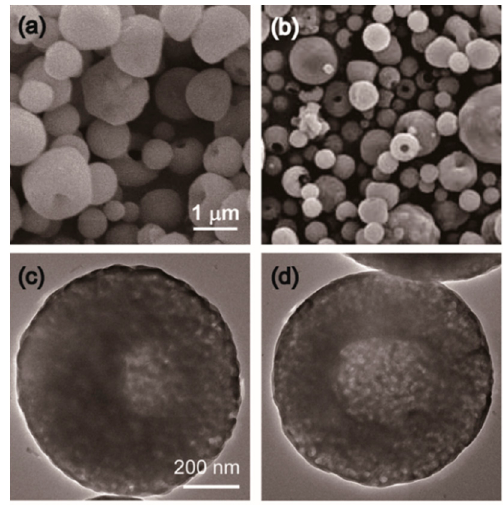
Figure 2. SEM and TEM micrographs of Ag-TCP powders. SEM images of washed sample powders of ( a ) Ag-TCP(0) and ( b ) Ag-TCP(5). Bar indicates 1 µ m. High-resolution of TEM images of washed sample powders of ( c ) Ag-TCP(0) and ( d ) Ag-TCP(5). Bar indicates 200 nm.